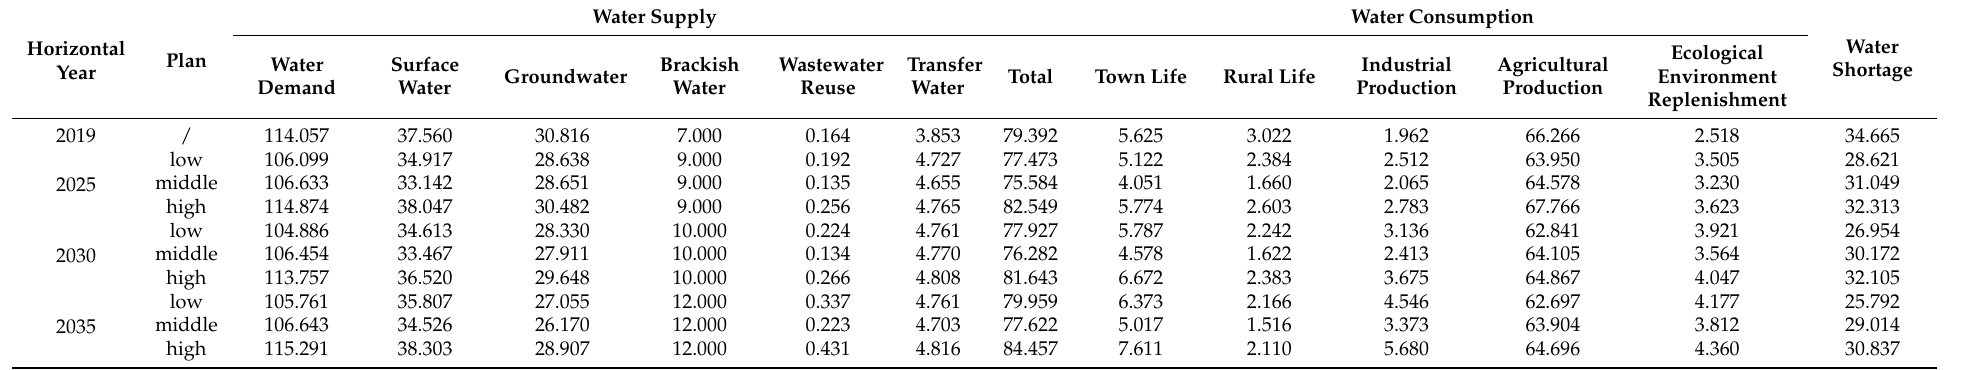
Table 5. Water resources allocation results under different schemes (10 6 m 3